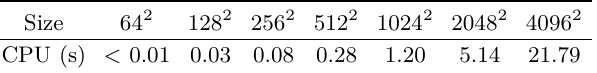
Table 7 CPU time to perform FM on the “Phantom” dataset of different sizes Size 64 2